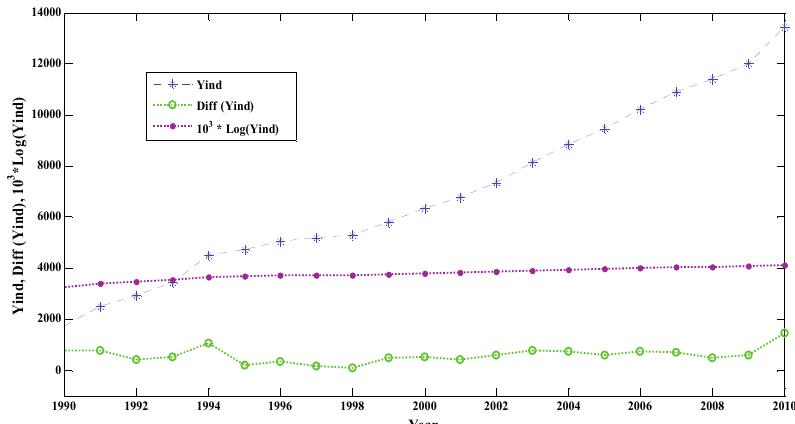
Fig. 1. Industrial peak demand time series (Yind) and its logarithm and differencing transformation